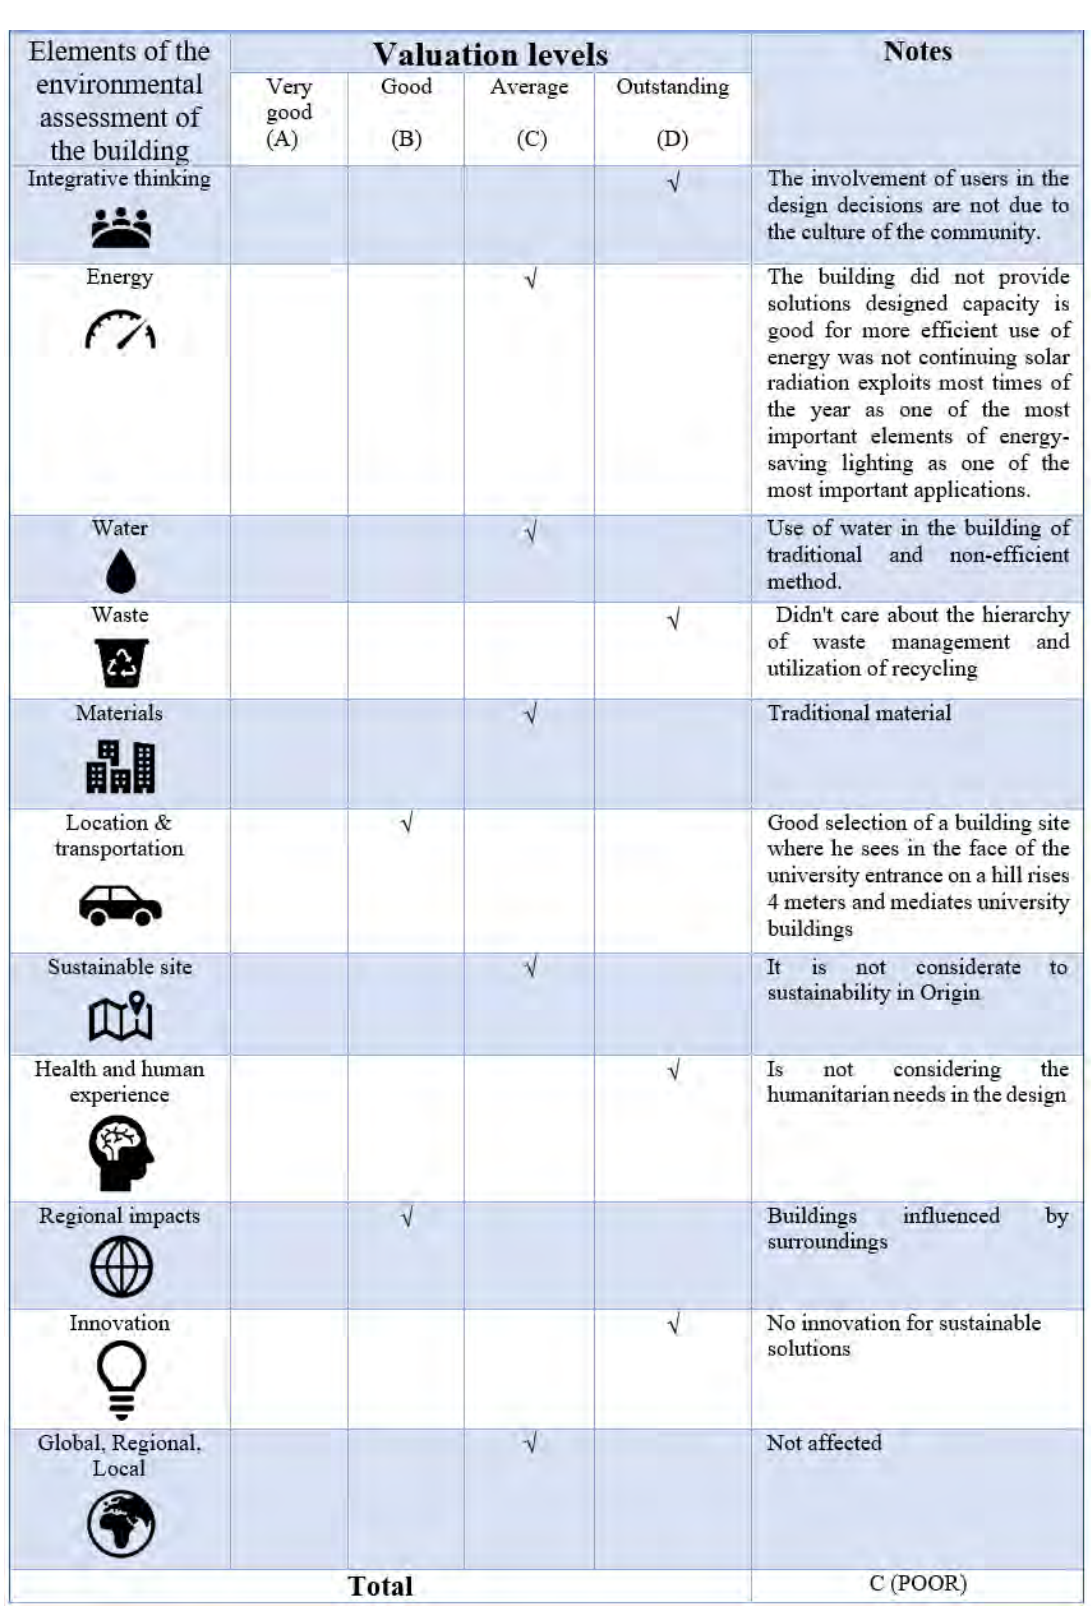
Table 1: Environmental